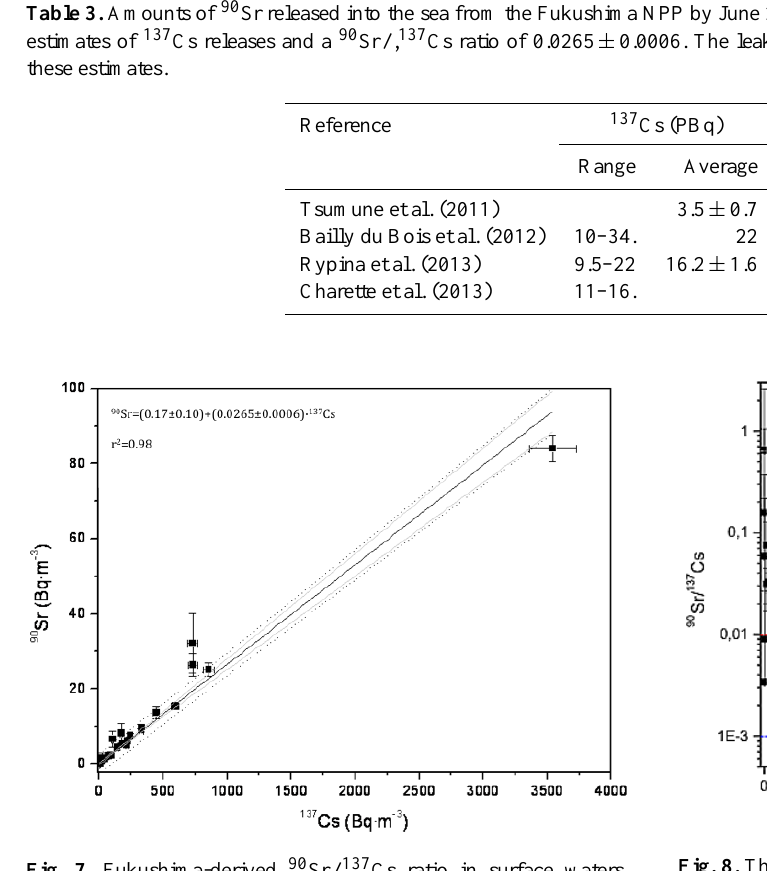
Fig. 7. Fukushima-derived 90 Sr/ 137 Cs ratio in surface waters. Background concentrations of both 137 Cs (2.1 ± 0.5Bqm − 3 ) and 90 Sr (1.2 ± 0.2Bqm − 3 ) have been subtracted. 137 Cs values are taken from Buesseler et al. (2012), which were collected simultane- ously with the samples for 90 Sr presented in this study. The average 90 Sr/ 137 Cs ratio is 0.0265 ± 0.0006.